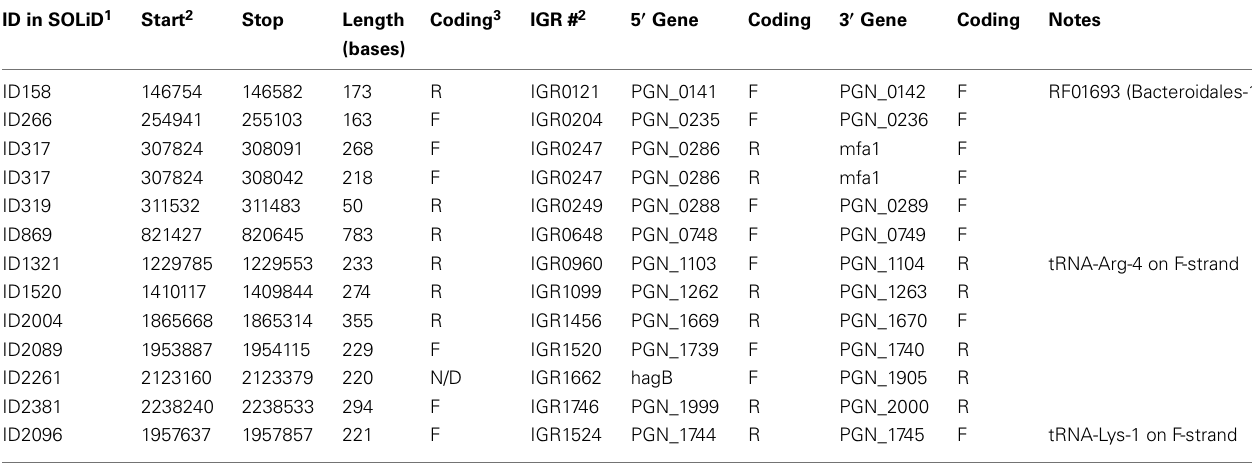
Table 1 | List of sRNAs identified by